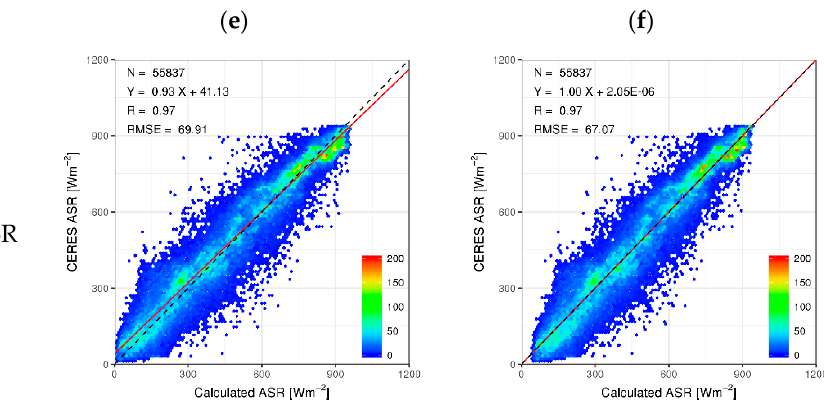
Figure 4. Density scatter plot of calculated shortwave radiation components and CERES shortwave radiation before ( a , c , e ) and after ( b , d , f ) calibration. Here, N is the total number of samples used for verification. The black dash line is the 1:1 line and the red line is the regression line. The unit of RMSE is Wm − 2 .